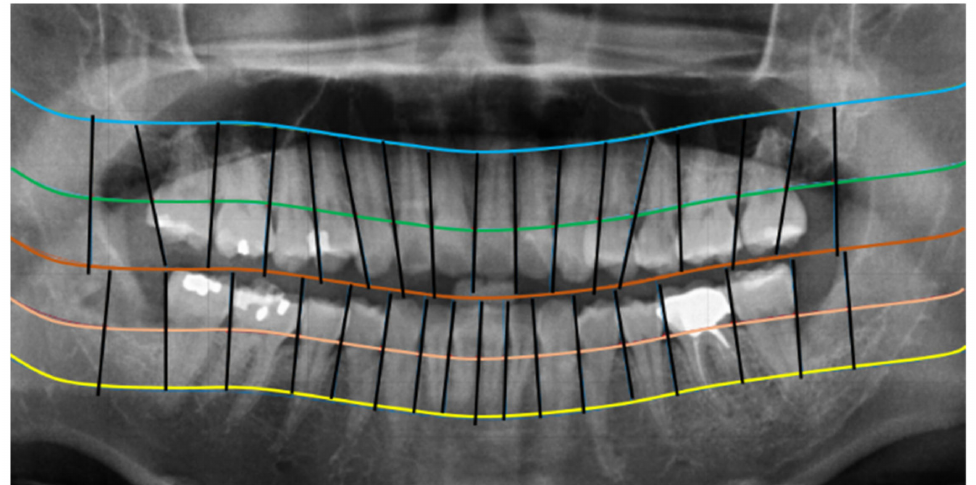
Figure 25. Completion of tooth cutting.